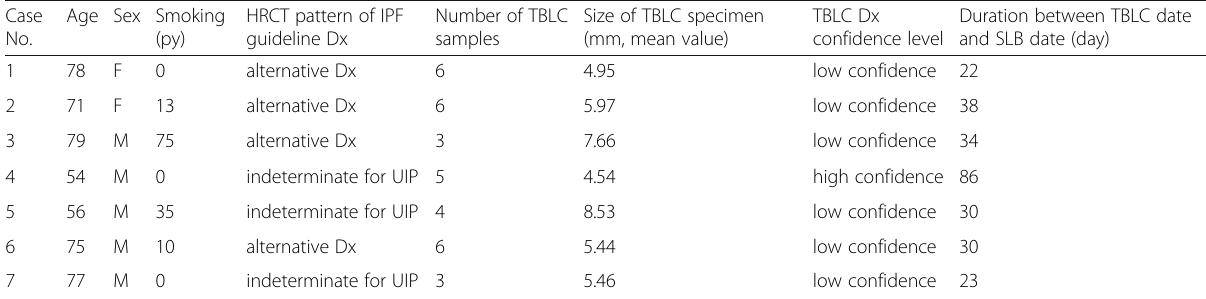
Table 1 Clinical data, HRCT pattern of IPF guideline Diagnosis, and TBLC status of all 7 cases Case No.